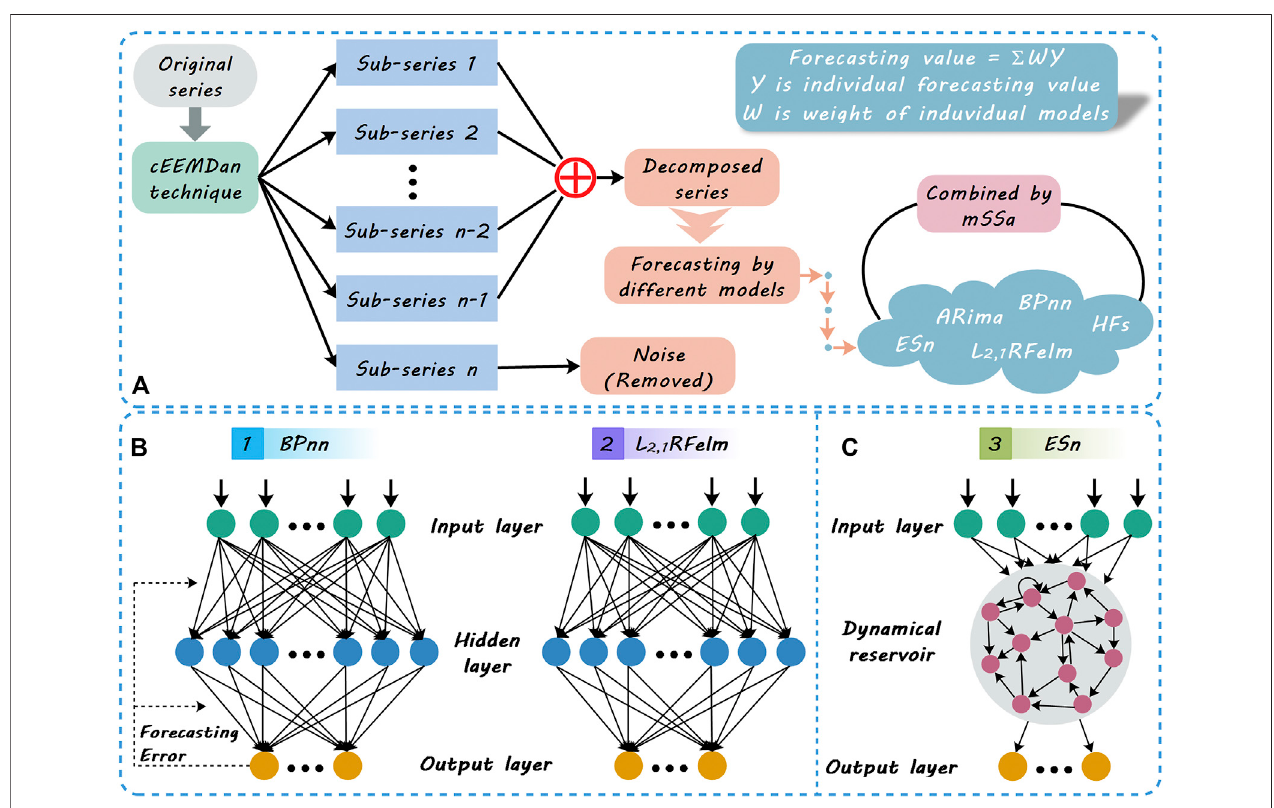
FIGURE 1 | (A) is the fl owchart of the proposed combined system; (B) and (C) are the structures of the neural networks used in this paper, where BPnn and ℓ 2,1 RFelm have the same structure and different solution